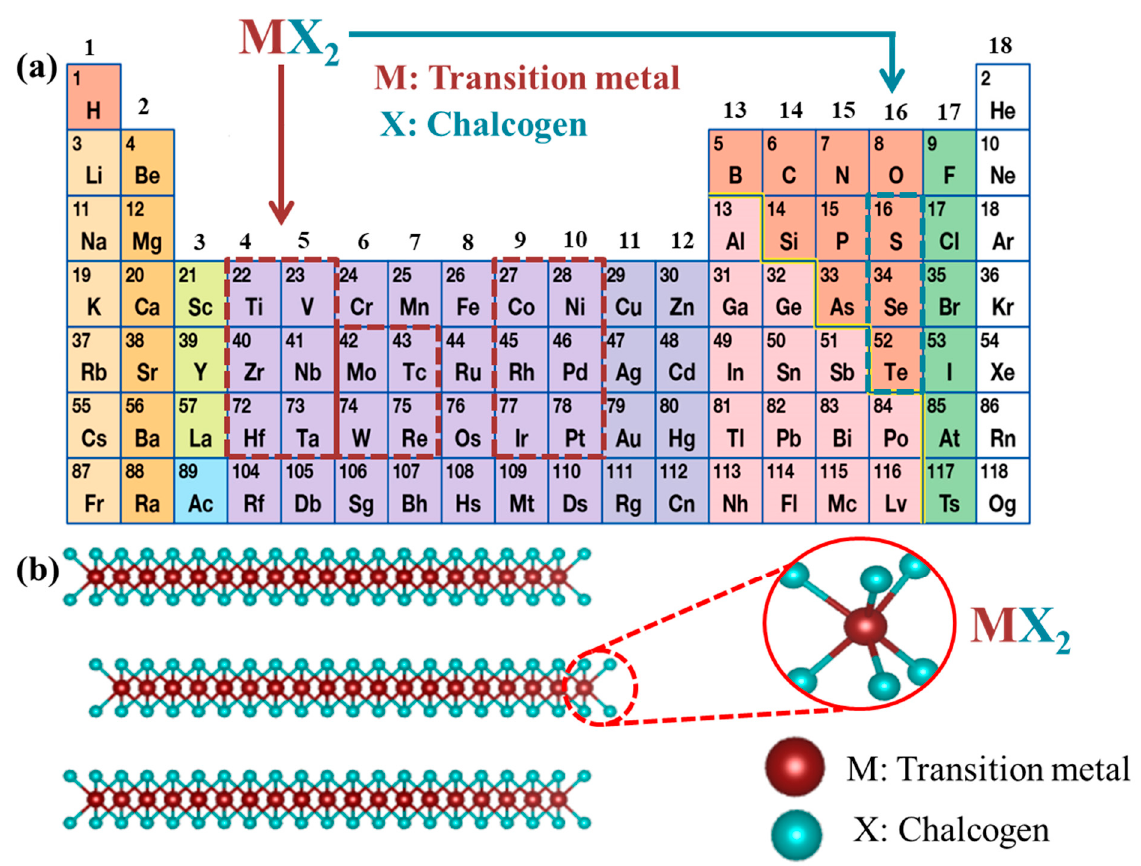
Figure 2. ( a ) TMDs with the MX 2 structure consisting of M from the 16 transition metals indicated by the red dotted box and X from the three halogen elements indicated by the green dotted box, ( b ) layered structure of MX 2.